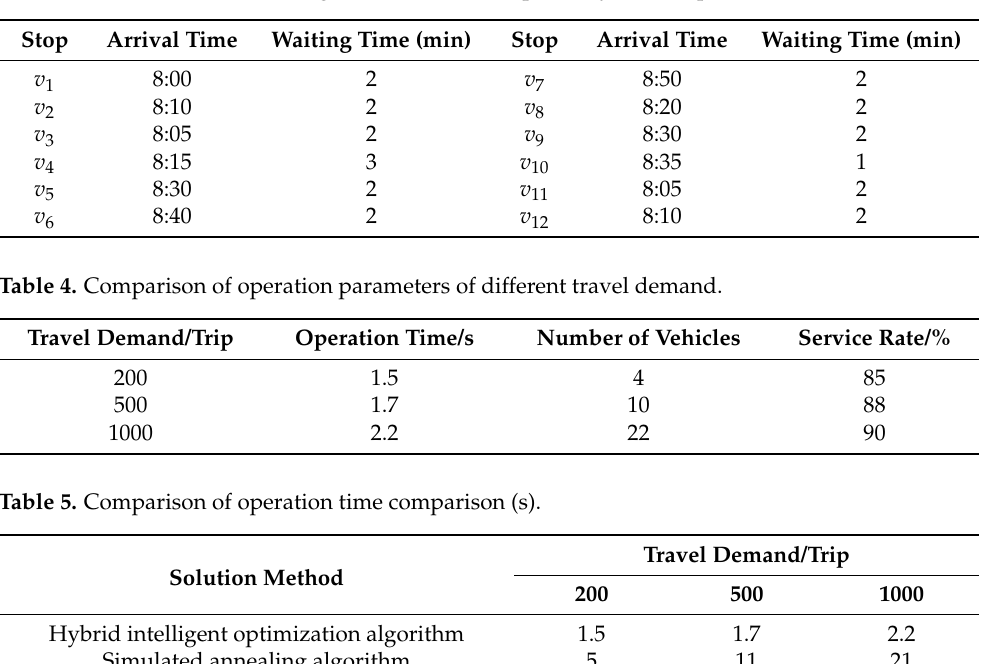
Table 3. Arrival time and waiting time of vehicles required by each stop.